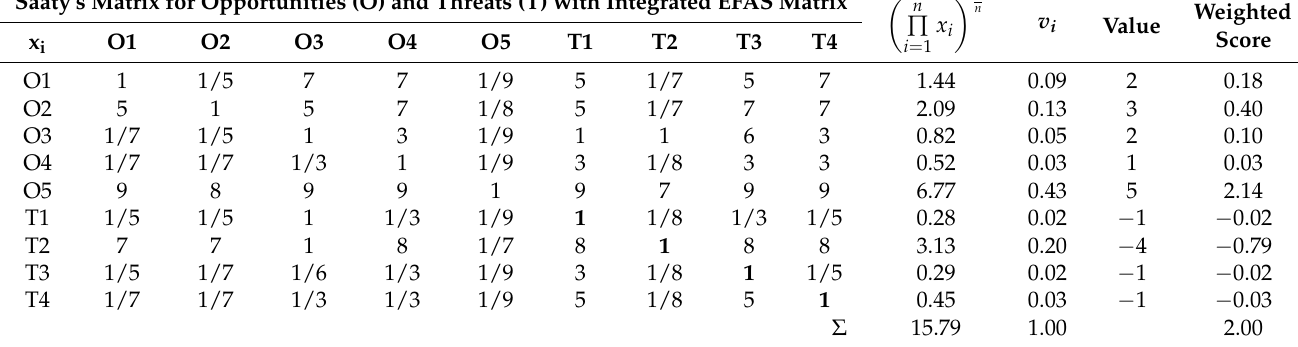
Table 6. Pairs preference using Saaty’s method with integrated external factors analysis (EFAS) matrix (Source: Own